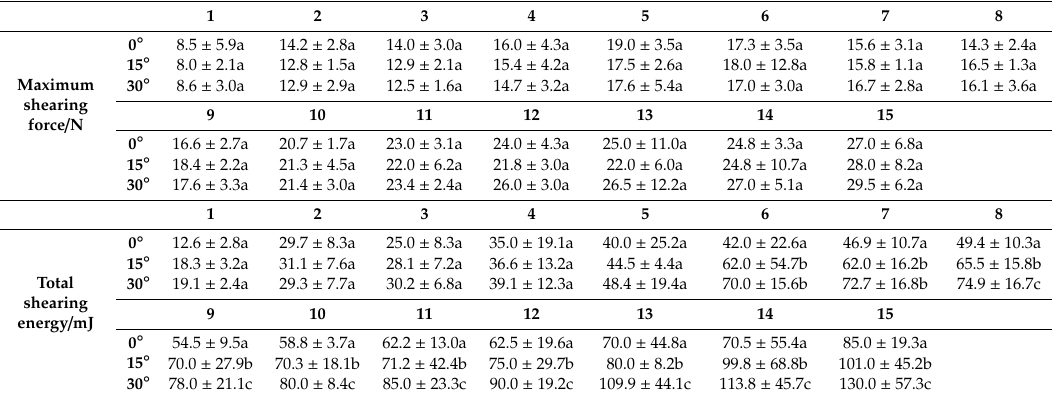
Table 2. Shearing properties on di ff erent cutting positions and angles.